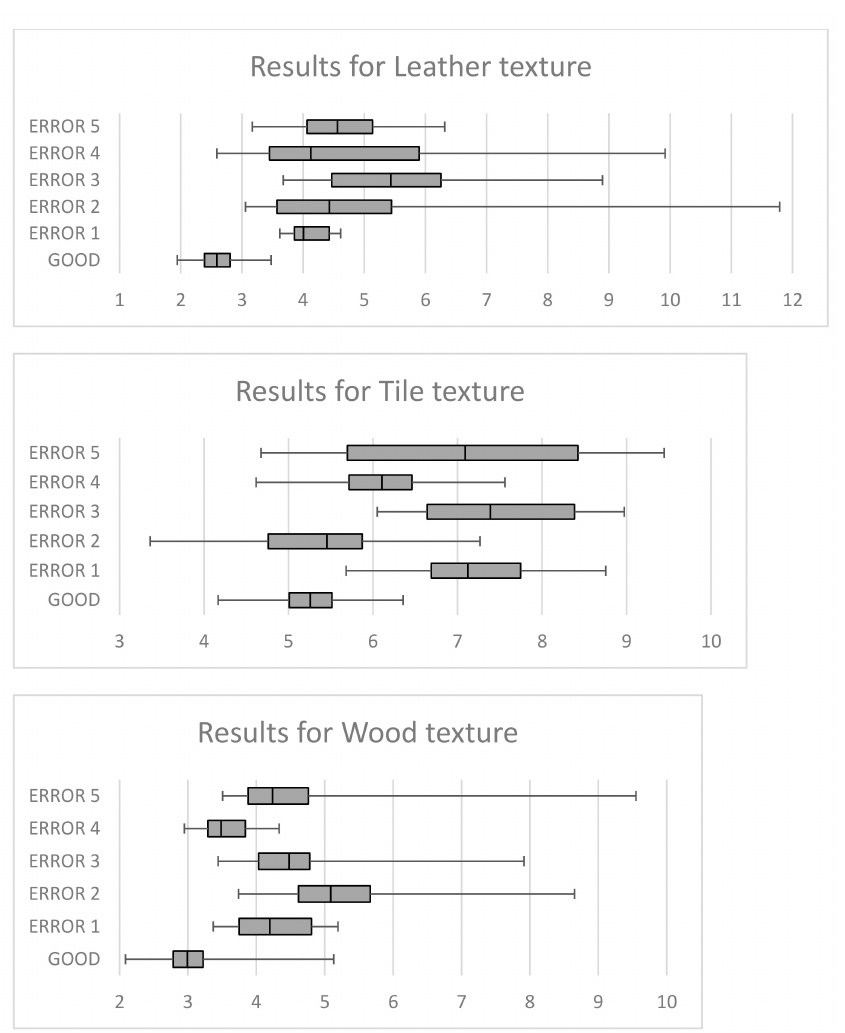
Figure 8. Reconstruction errors for the different textures.